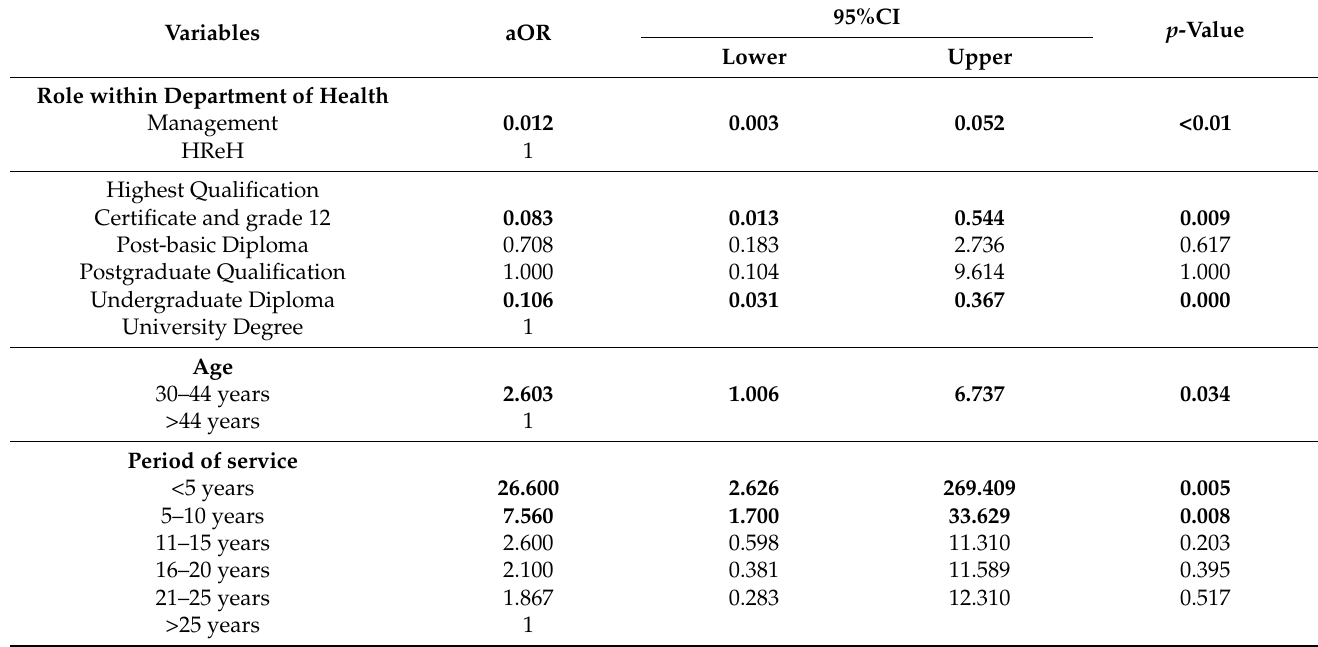
Table 6. Association between practices and demographic